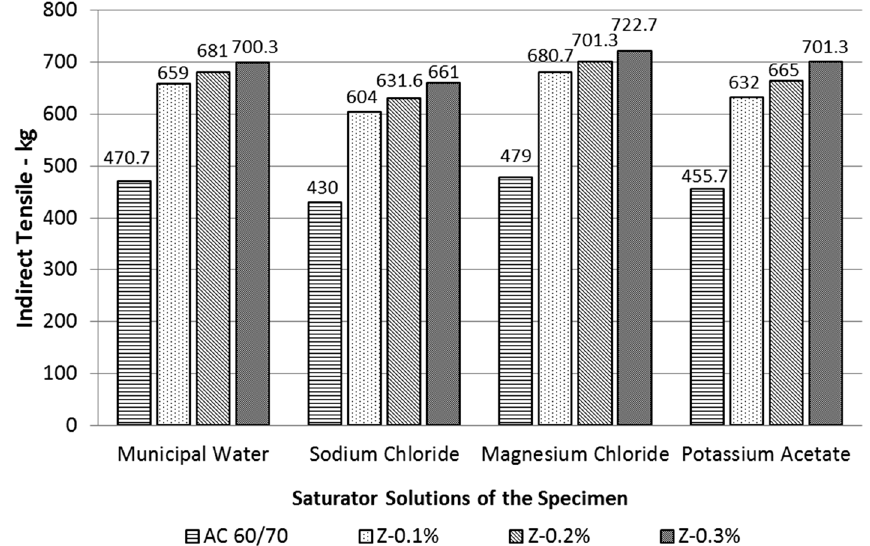
Fig. 7 Indirect Tensile Strength (ITS) of all mixes under moist condition (saturated with dif- ferent deicing